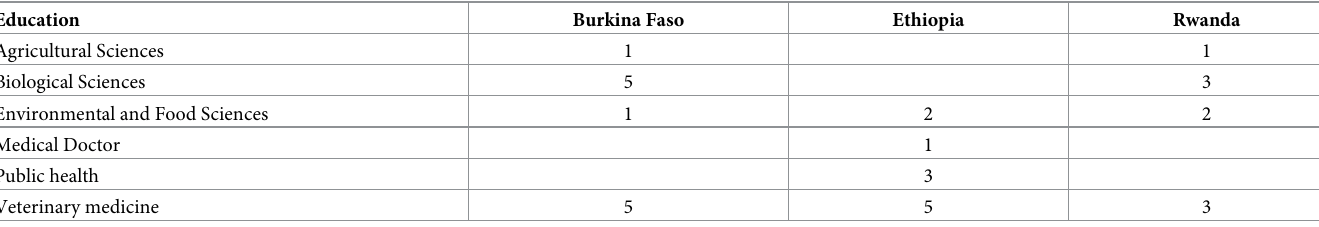
Table 2. Expert educational backgrounds (highest degree